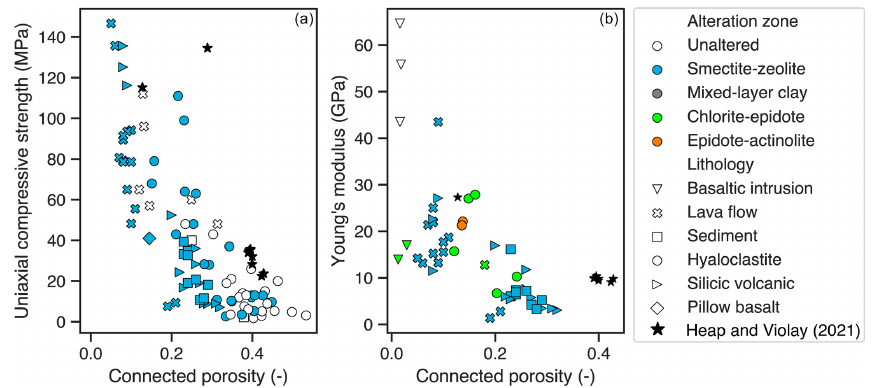
Figure 14. (a) Uniaxial compressive strength (UCS) and (b) Young’s modulus as a function of connected porosity. Data for Icelandic rocks are from Heap and Violay (2021) and are shown using black stars.